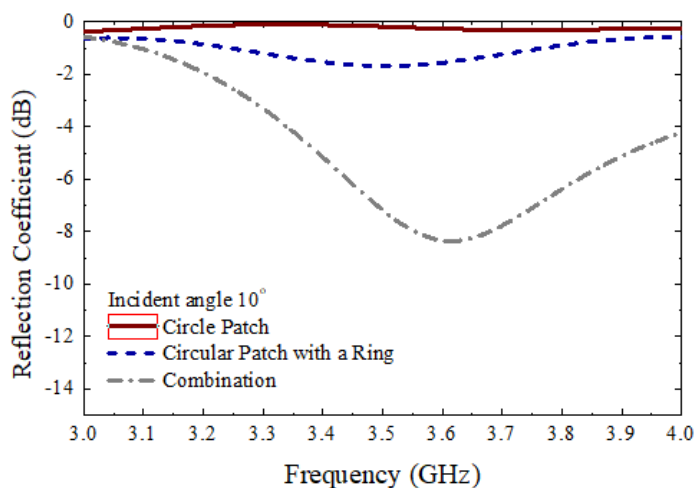
Figure 12. Measured reflection coefficients for three different types of arrays at an incident angle of 10 °.